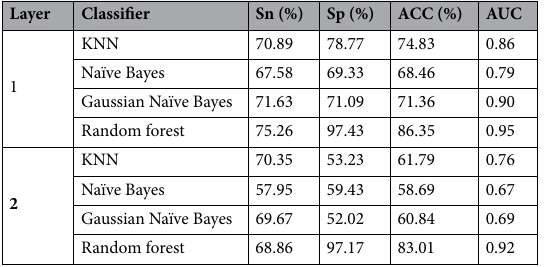
Table 7. Jackknife test comparison of machine learning algorithms for predicting enhancers and their strengths.